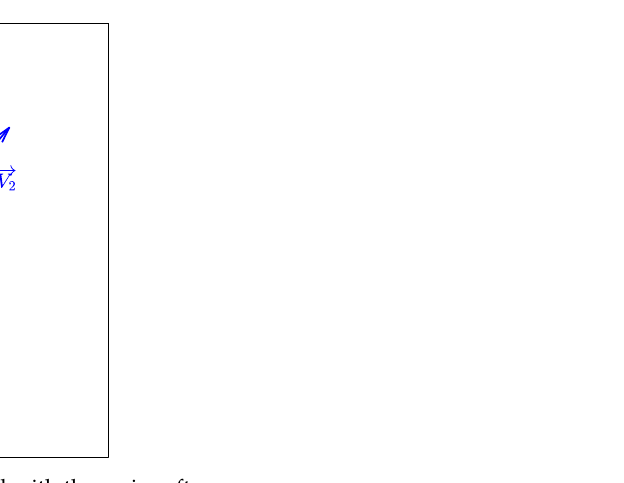
Figure 6. Uncertainties associated with three aircraft.